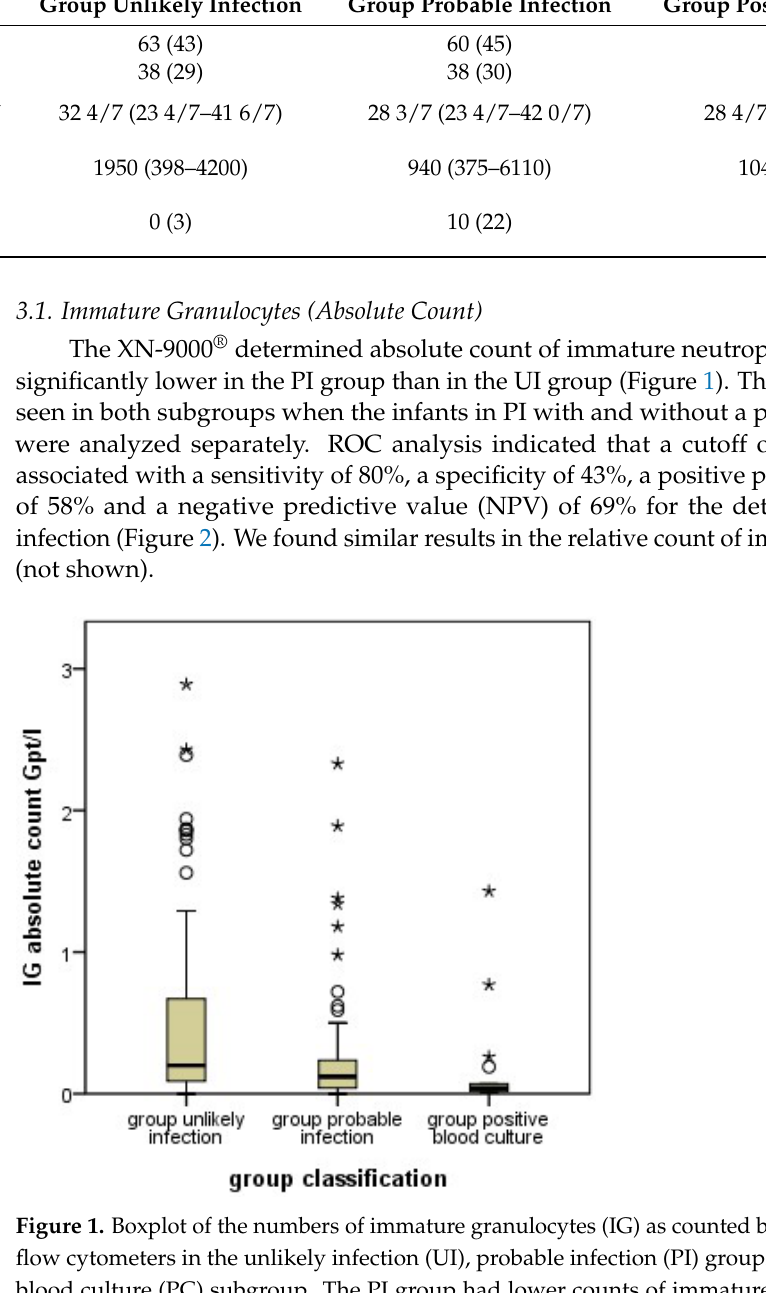
= outliers, (cid:35)